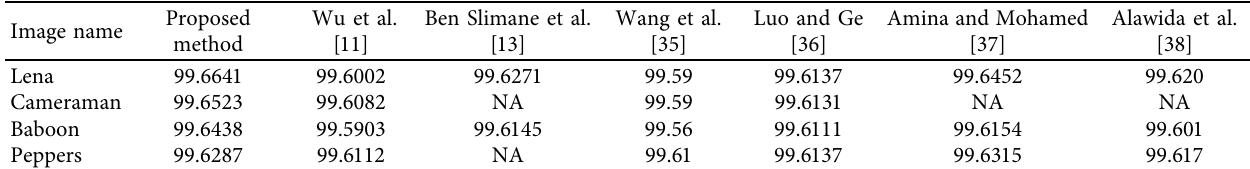
Figure 17: The effect of speckle noise attack: (a) encrypted picture with 5% salt & pepper noise; (b) encrypted picture with 4% speckle noise; (c) cipher picture with 2% Gaussian commotion and turn of 30 ° ; (d) decrypted image with 5% salt & pepper noise; (e) decrypted image with 4% speckle noise; and (f) decrypted image with 2% Gaussian noise and turn of 30 ° . Table 3: The NPCR (%) of encrypted images for our approach compared with other literature algorithms. Please note that NA stands for “not applicable.”